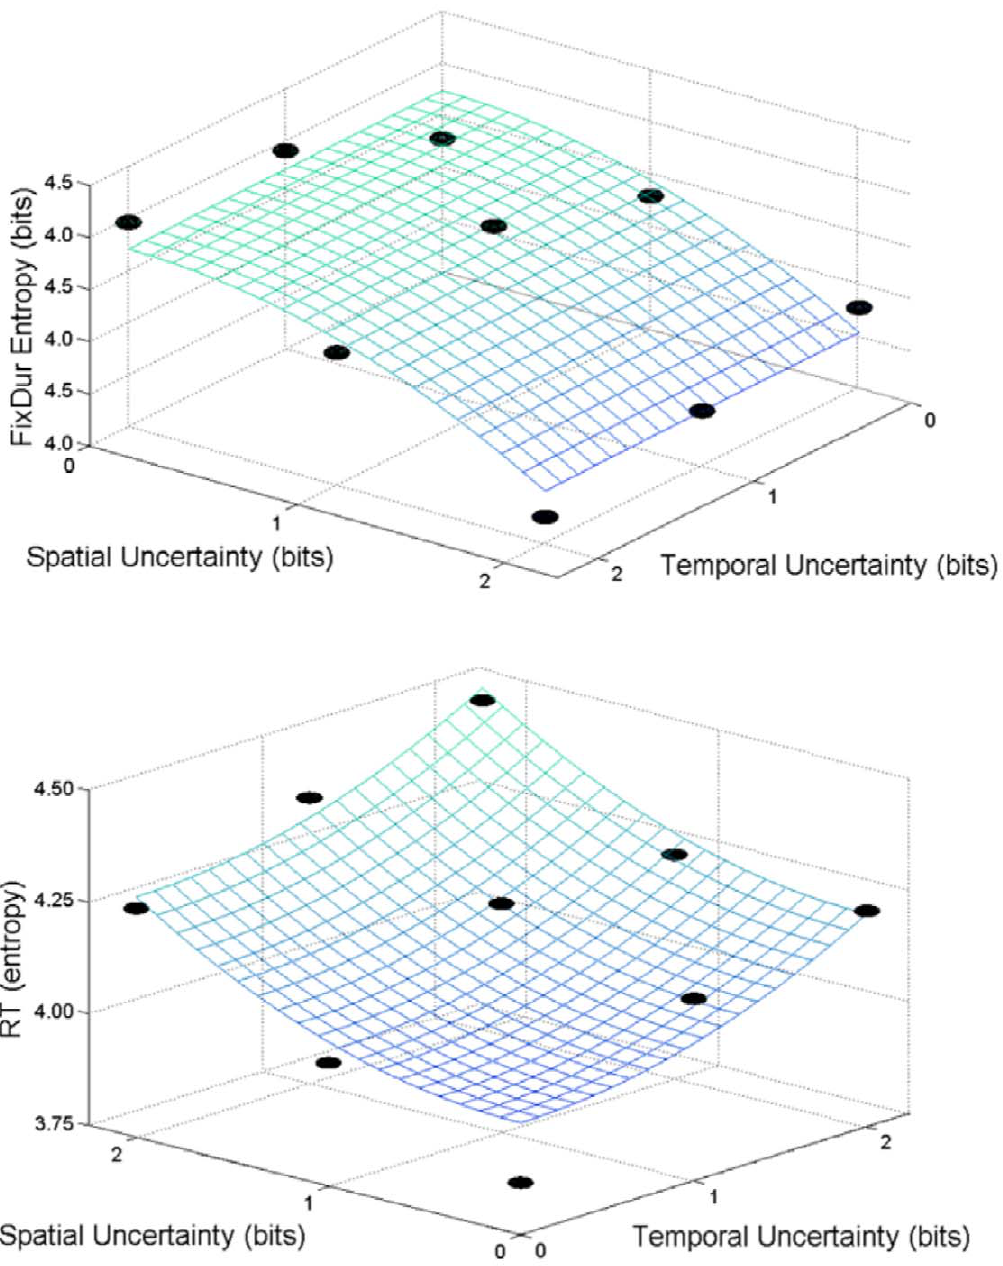
Figure 4. Results of the least-squares regression. Quadratic surfaces generated from the coefficients obtained from the least-squares regressions (Eq. 2 and 3), where eye fixation duration and RT entropy are presented as a function of the spatial and temporal uncertainty of the visual stimulus. Upper panel presents the surface obtained from the least squares fit to the eye fixation duration entropy data. Lower panel presents the results of the least squares fit to the RT entropy